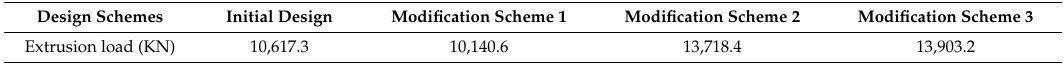
Table 5. Required extrusion load for the different design schemes.